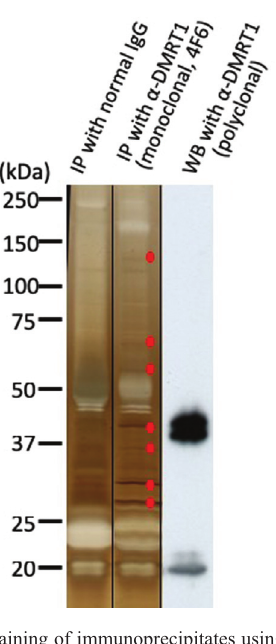
Figure 2 - Silver staining of immunoprecipitates using the anti-DMRT1 monoclonal antibody 4F6 from X. laevis adult testes. Testis extracts were mixed with normal mouse IgG or the anti-DMRT1 antibody 4F6, and pulled down with protein A/G agarose. The immunoprecipitates were ex- amined by silver staining (the right and middle lanes) or immunoblotted with an anti-DMRT1 polyclonal antibody (right lane). Seven 4F6-specific bands were excised, and examined by LC-MS.